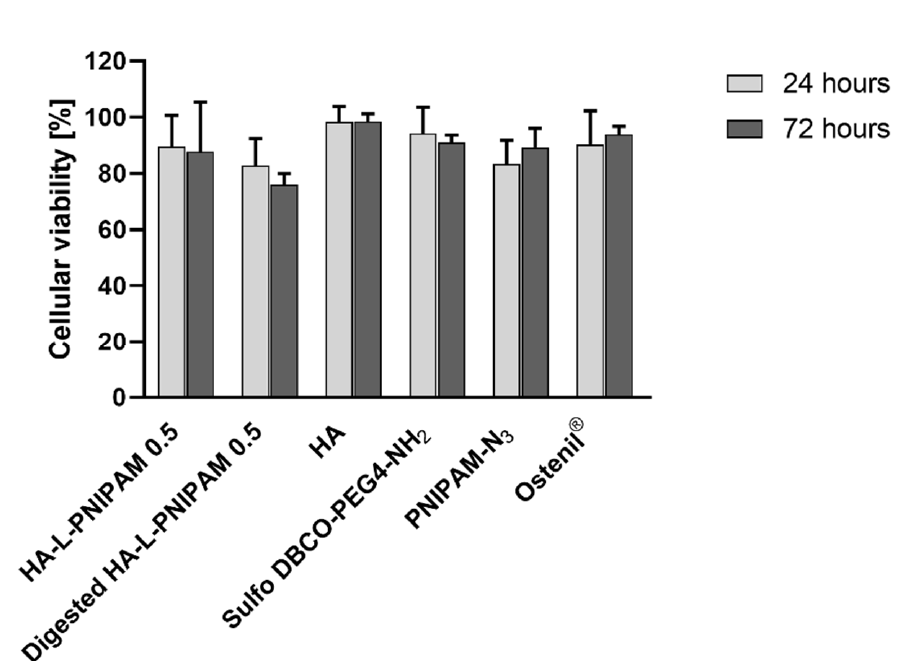
Figure 5. The cellular viability (WST-1 mitochondrial activity assay) of human fibroblast-like synoviocytes (HFLS) incubated with HA-L-PNIPAM 0.5 5%, HA-L-PNIPAM 0.5 5% digested by hyaluronidase, hyaluronic acid 0.71% (2200–2400 kDa), Sulfo DBCO-PEG4-NH 2 0.21%, PNIPAM-N 3 4.08% (15,000 Da) and Ostenil ® after 24 h and 72 h. No statistically significant differences ( p > 0.05) with the control (cell culture medium) were observed for all conditions ( n = 4; ±sd).